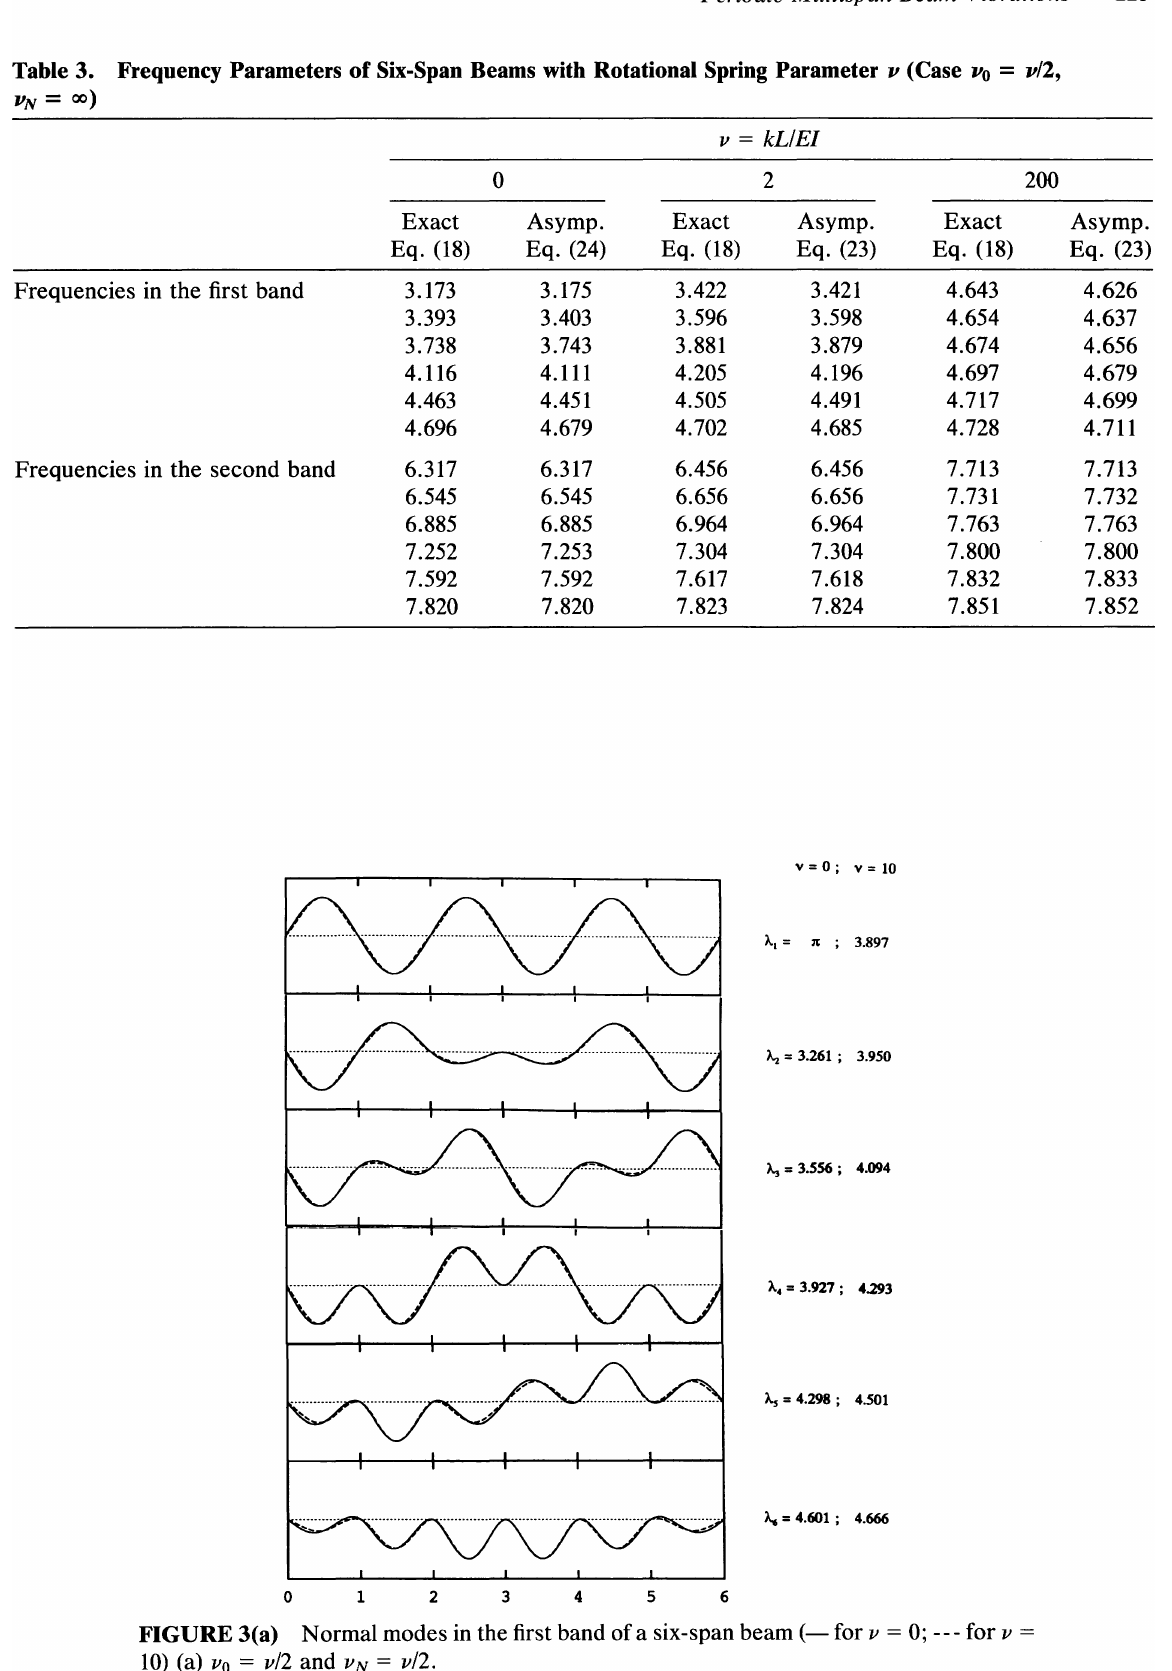
FIGURE 3(a) Normal modes in the first band ofa six-span beam (- for v = 0; --- for v = 10) (a) Vo = v/2 and VN =